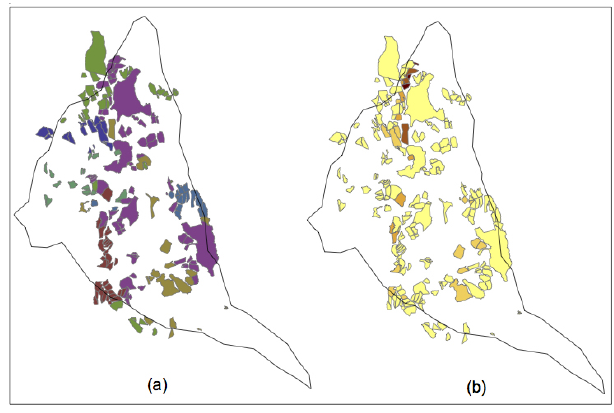
Fig. 5 . Spatial distribution of plot-level community structure (a) and plot centrality (b).